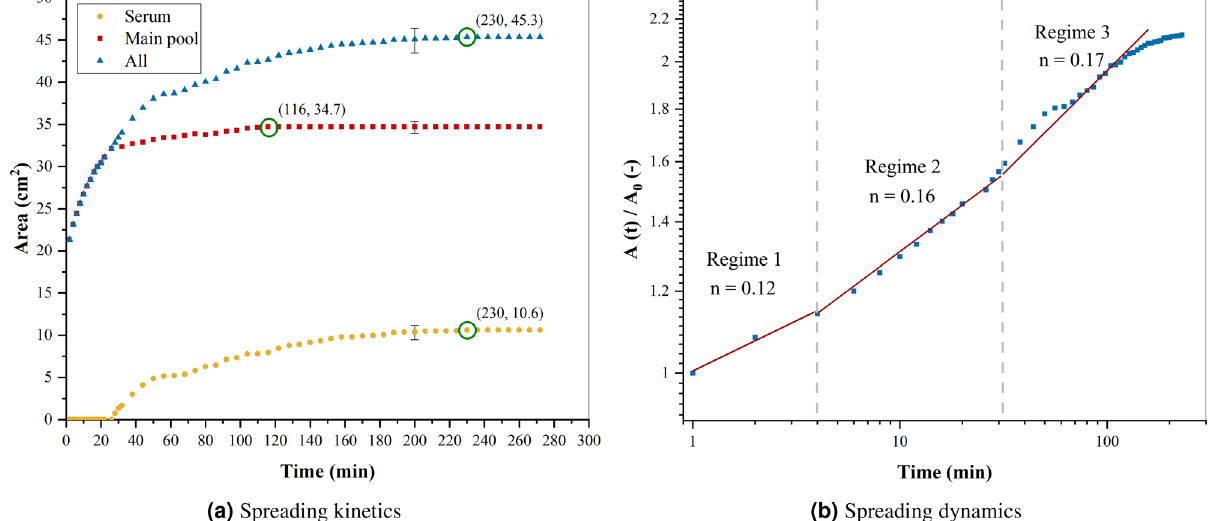
Figure 5. ( a ) Spreading kinetics of a blood pool ( m i = 4.82 g , hct = 41.5% ) on varnished wooden floors at 21 ◦ C with a relative humidity of 60% . ( b ) Log-log plot of the time evolution of the rescaled total pool area at 21 ◦ C with a relative humidity of 60% . The red line is a guide for the eyes, with three different values of slope.A typical error bar is presented on a single point of each curve. (OriginPro